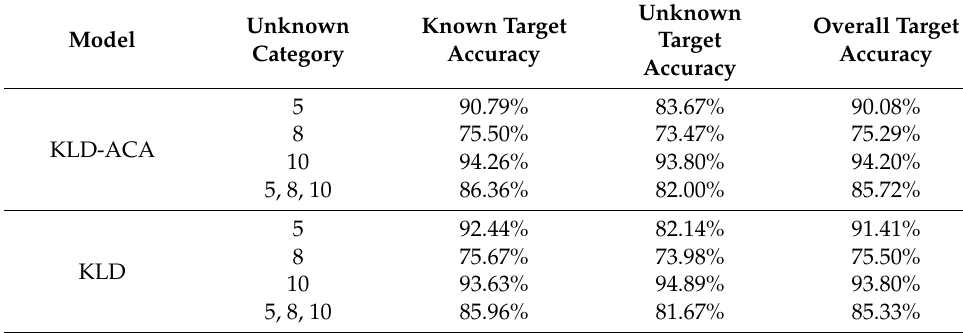
Table 9. Results of 3-type unknown target test on KLD-ACA and KLD